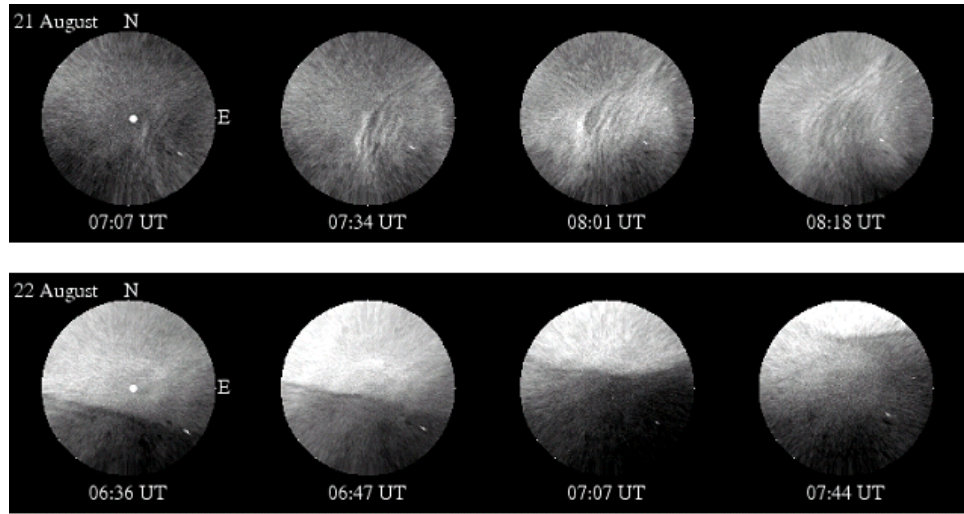
Fig. 11. Examples of mesospheric structures seen in geometrically-corrected 557.7nm images. The top panel shows small scale gravity wave disturbances on 21 August 2001, exhibiting markedly curved wave-fronts indicative of a nearby source. The bottom panel shows a large scale mesospheric bore event propagating from the south on the subsequent